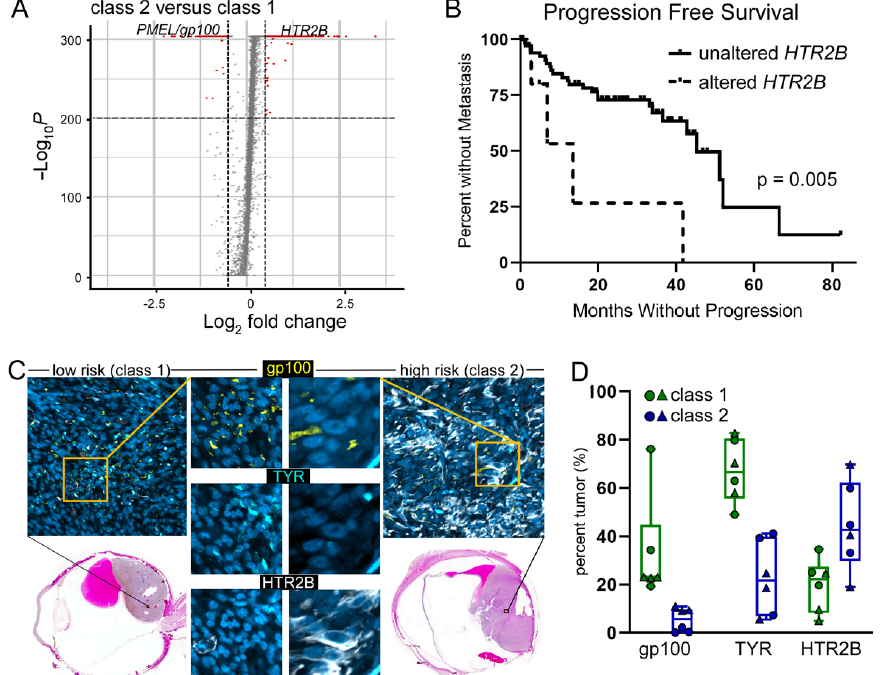
Figure 2. Validation of gene elevated in high risk tumors. ( A ) Volcano plot of differential gene expression between class 2 and class 1 tumors from a publicly available single cell RNA-seq dataset. ( B ) TCGA uveal melanoma dataset of n = 79 patients analyzed for altered expression of HTR2B correlated with progression free survival. ( C ) low risk (class 1) and high risk (class 2) tumors stained with antibodies to gp100 (yellow), TYR (blue) and HTR2B (white) merged in the image. Individual antibody staining shown at higher magnification of the boxed region. Hematoxylin & eosin stained image of the same region of the globe is shown. ( D ) Quantification of protein staining from three regions of interest from each tumor.